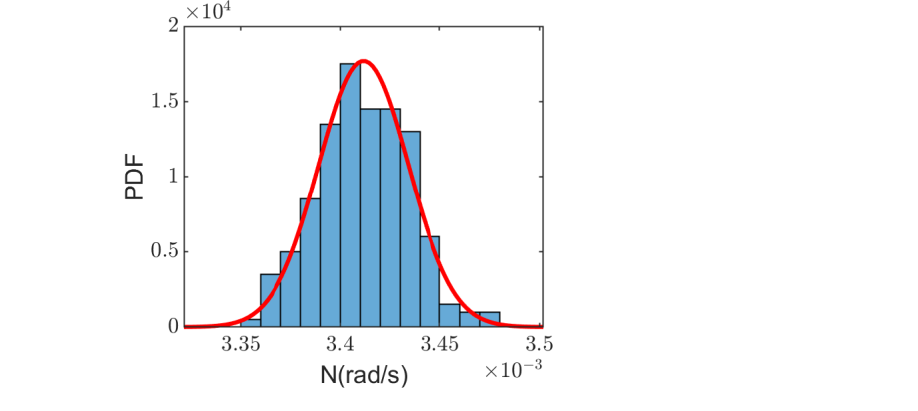
Figure A4. The histogram of buoyancy frequency at 600 m depth. The red line represents the PDF of fitted normal distribution.